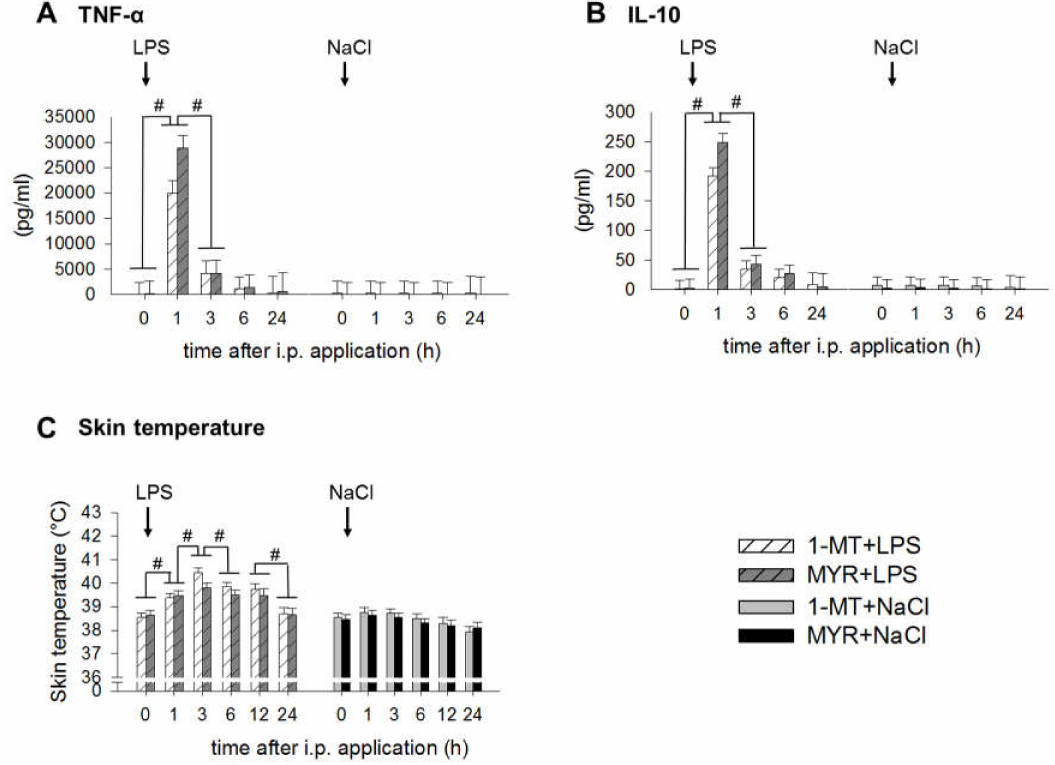
Figure 5. Effects of LPS on plasma TNF- α ( A ), plasma IL-10 ( B ) and skin temperature ( C ) and its interference by 1-MT. Treatment with NaCl and pre-treatment with MYR were used as control groups. LPS or NaCl were injected i.p. directly after blood sampling at 0 h, respectively. The animals received the fifth s.c. 1-MT injection at 12 h after LPS/NaCl treatment to prevent a decline in 1-MT levels during the period of the LPS response. The cytokines TNF- α and IL-10 were quantified by ELISA. Skin temperature was measured using an infrared thermometer directly before blood sampling. All data are presented as LS-means ± SE. For multiple pair-wise comparisons Tukey–Kramer procedure was used. Significant differences between time points are indicated by hashes. For time points 0, 1, 3, 6 h: n = 11-12/group (total n = 47); for time points 12 and 24 h: n = 5-6/group (total n = 23); # p <